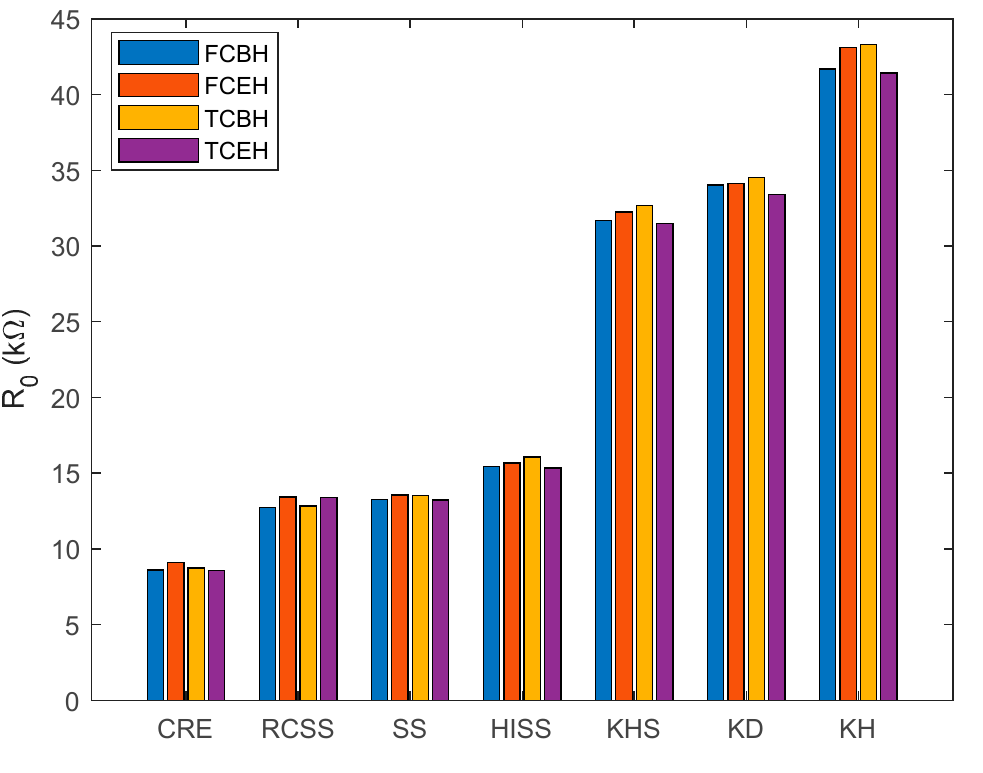
Figure 20. Initial resistance found by pinpointing direction of the cycle within the resistance vs. strain graph and noting the proper value before deriving the slope.